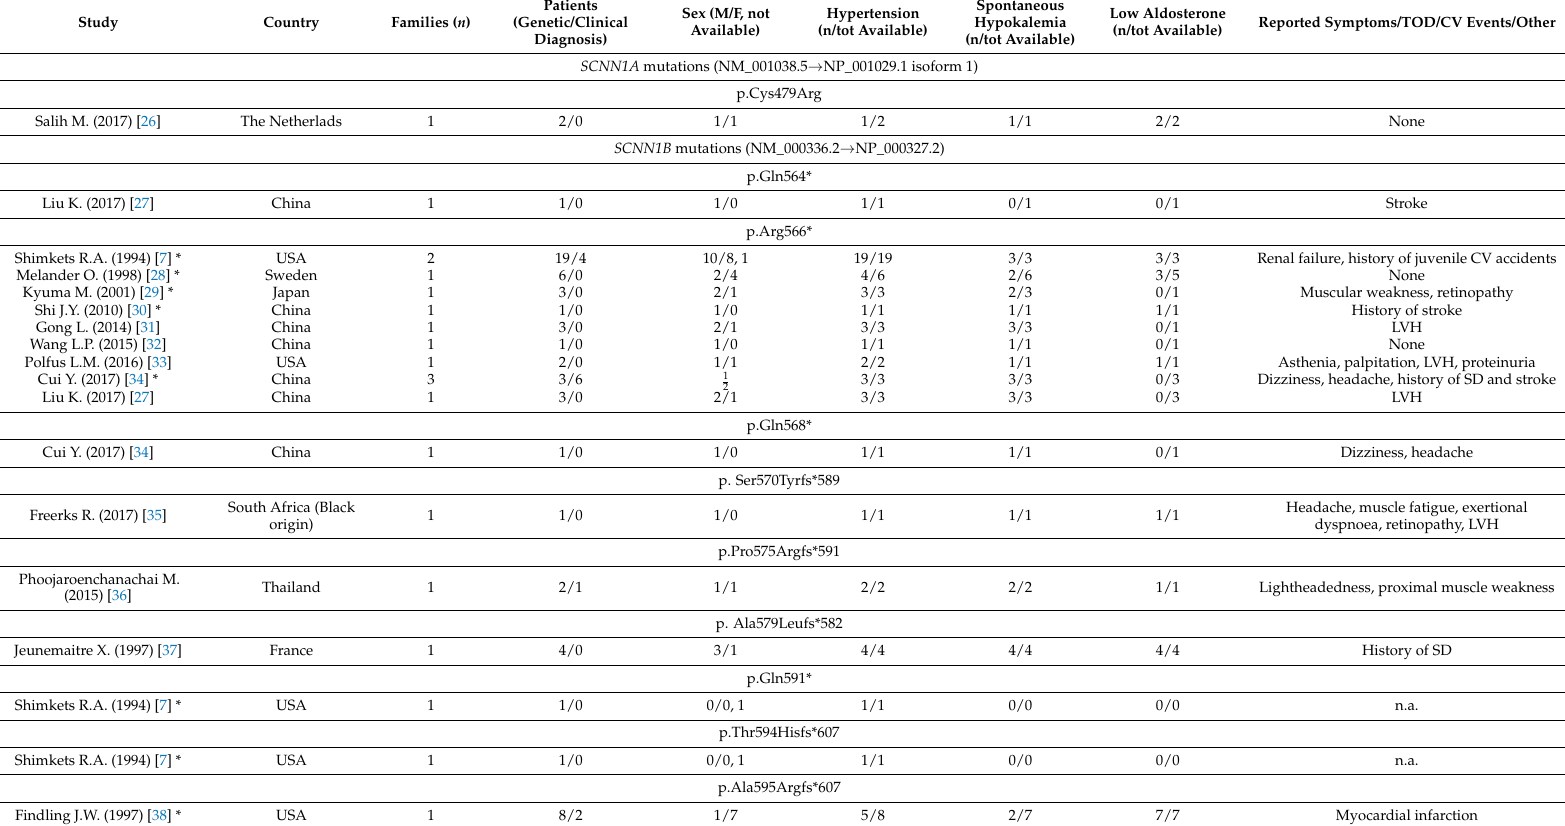
Table 1. Clinical and biochemical phenotype of patients affected by Liddle’s syndrome. *—in the original manuscript the mutation is reported according to the homologous rat sequence, HT—hypertension, SD—sudden death, LVH—left ventricular hypertrophy, TOD—target organ damage, CV—cardio vascular, n.a.—not available. Hypokalemia defined as serum K + <3.5 mmol/L, hypoaldosteronemia defined as serum aldosterone <5 ng/dL or urinary aldosterone <5 µ g/24